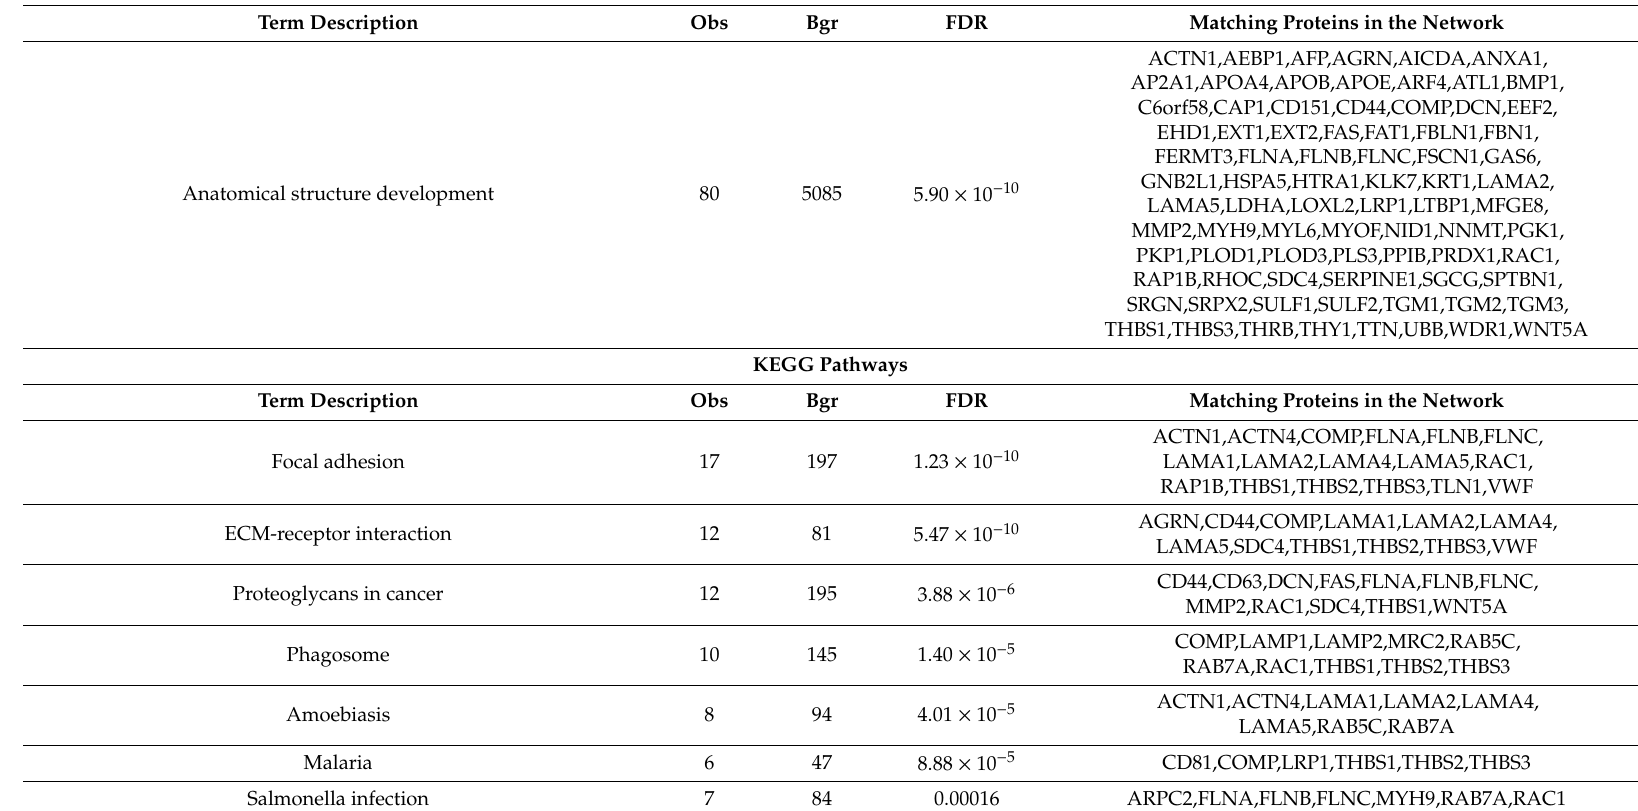
Gene Ontology (GO) Terms for Biological Processes10 Most Significant Results per FDR (for All GO Terms, See Supplementary Table